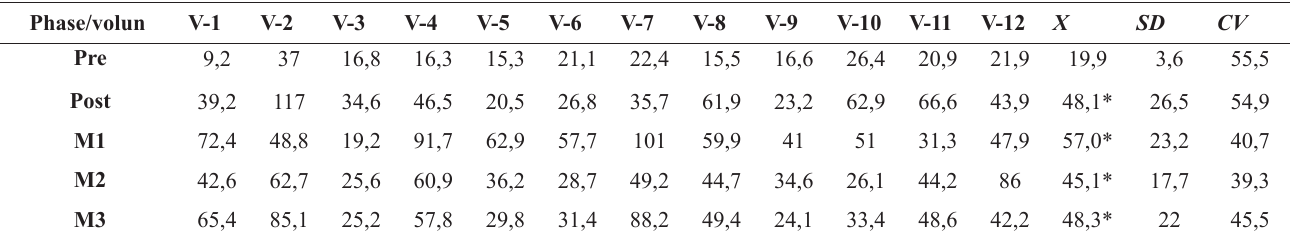
) throughout a máx